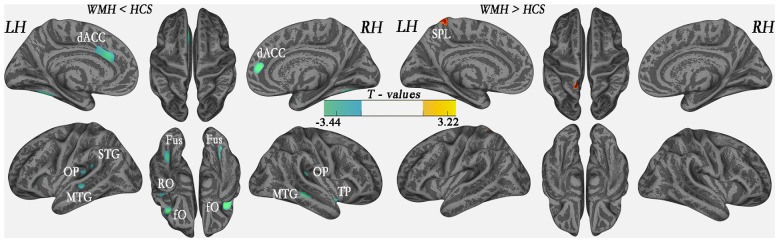
Comparison of local cortical thickness between the WMH group and the HCS group (P < 0.01, family-wise error (FWE)-corrected). Indigo indicates a significantly lower cortical thickness value, and yellow indicates a significantly higher cortical thickness value.